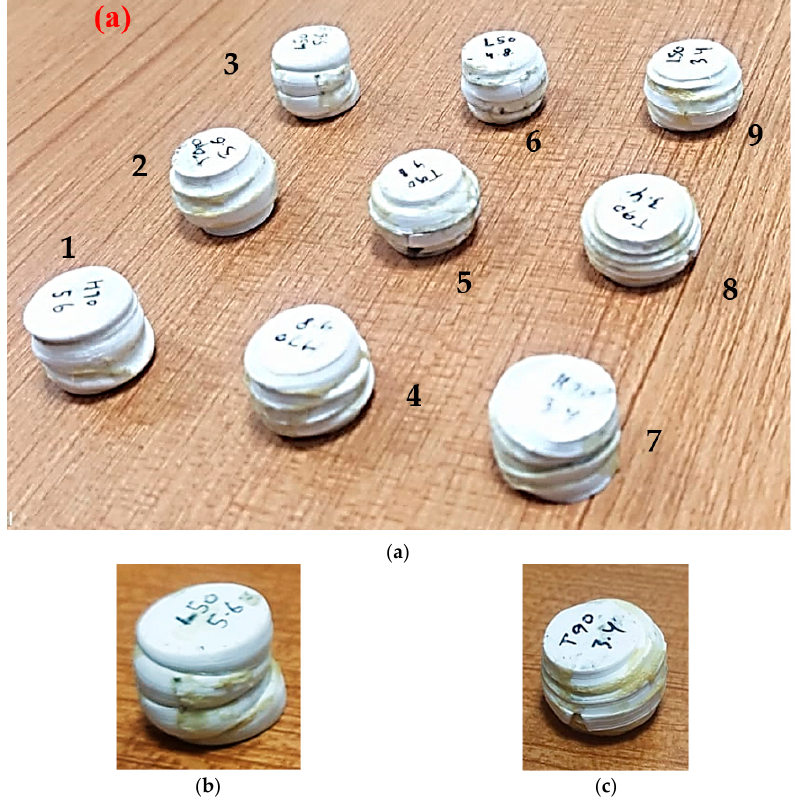
Figure 3. ( a ) PLA samples tested on the UTM for compressive strength, ( b ) sample 3 with the least mechanical performance, and ( c ) sample 8 with the maximum mechanical strength.